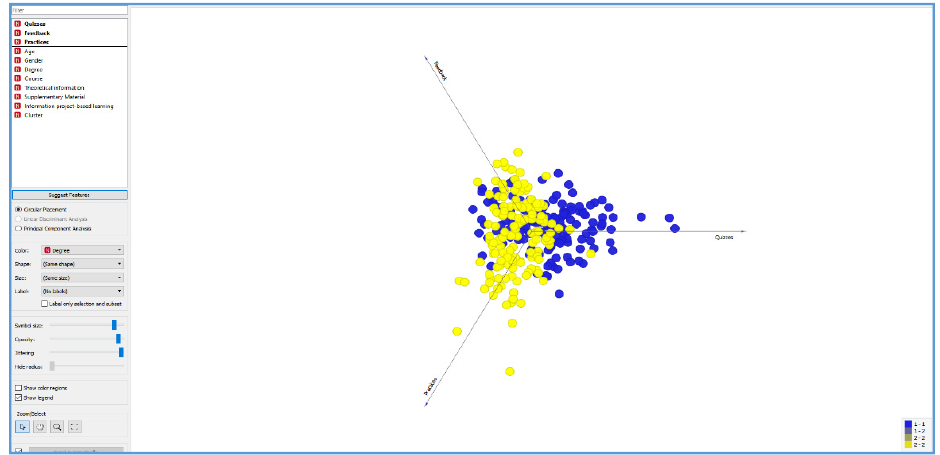
Figure 9. Visualization of the behaviour of students in both grades (nursing and occupational therapy) for variables with significant predictions.